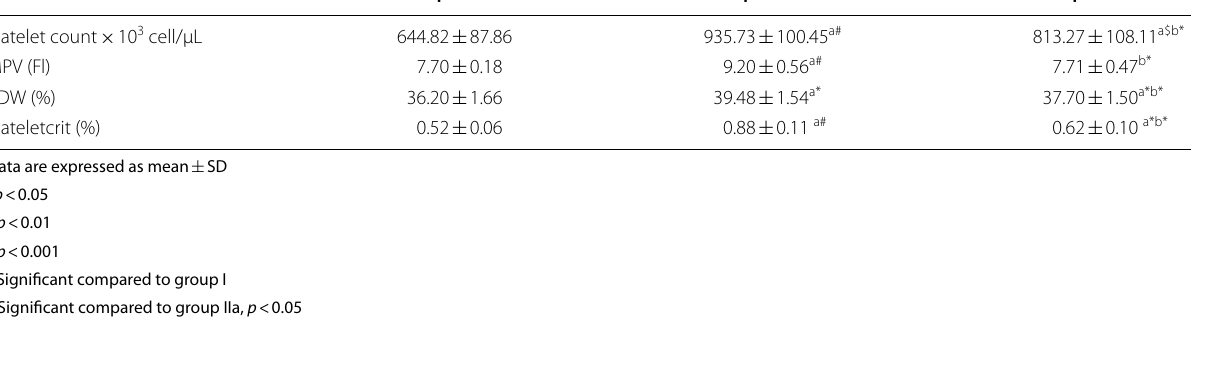
Table 3 Pearson correlation of sRAGE with glucometabolic and platelet parameters